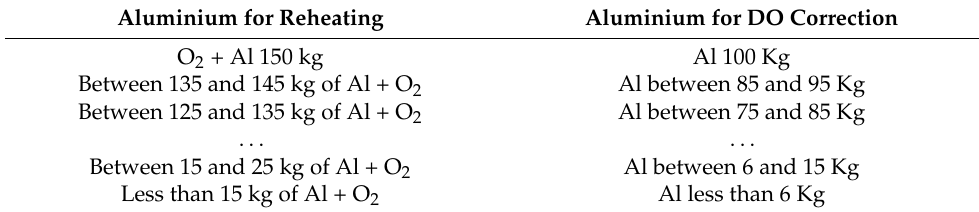
Table 4. Aluminum addition